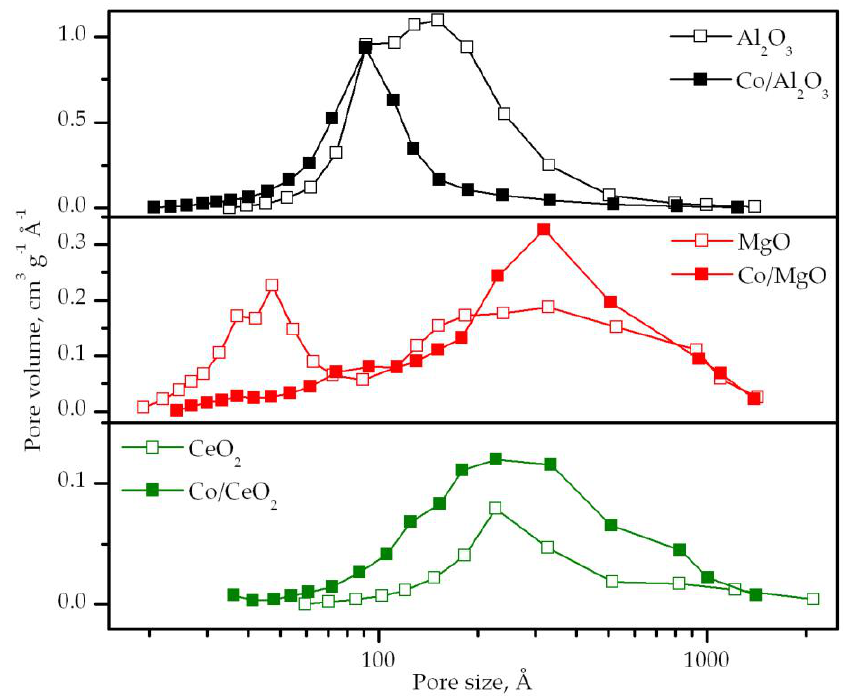
Figure 2. Pore size distributions of the bare supports and the supported cobalt catalysts.